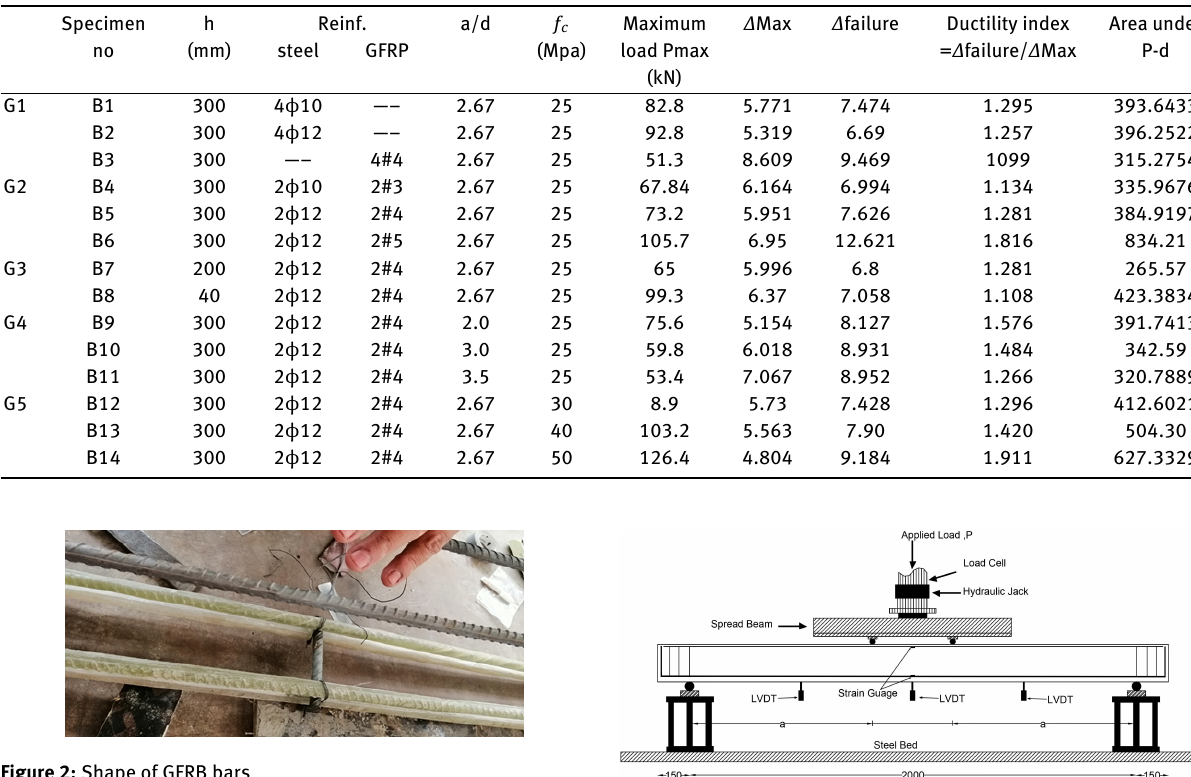
Figure 2: Shape of GFRB bars